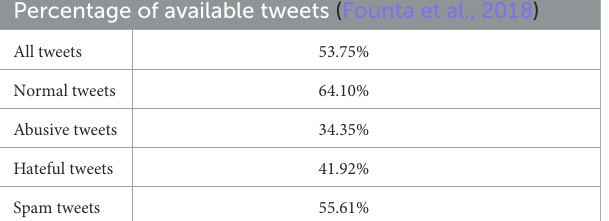
TABLE 8 In Founta et al. (2018)’s abuse detection dataset, tweets labeled as abusive, hateful or spam became unavailable at higher rates than normal